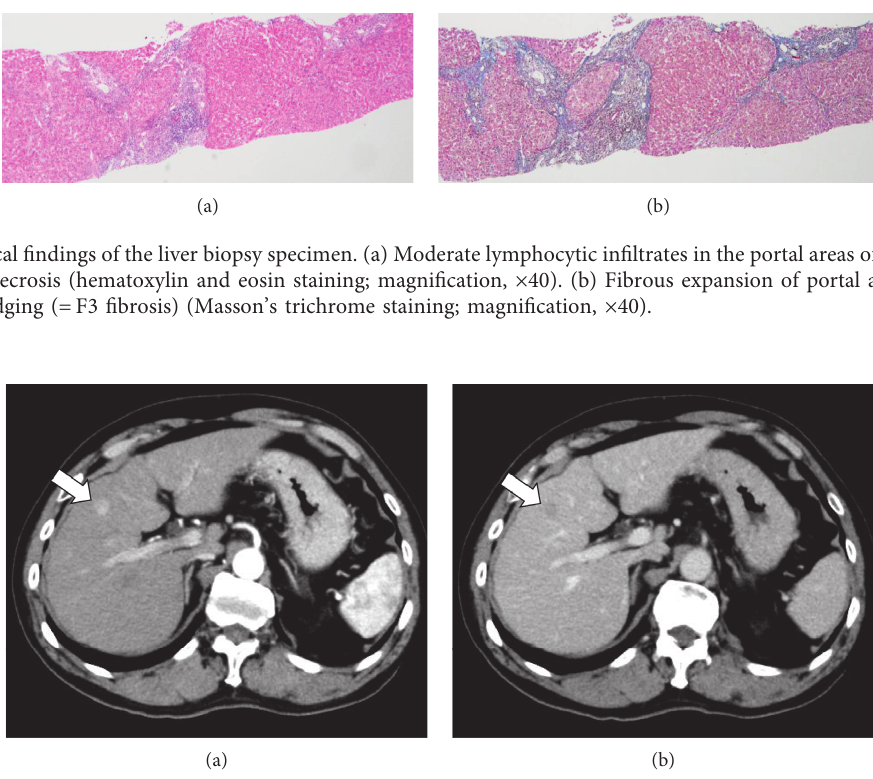
Figure 2: Contrast-enhanced CTshowing the tumor (a) markedly enhanced in the arterial phase (b) followed by a relatively quick wash-out during the equilibrium phase (arrow).